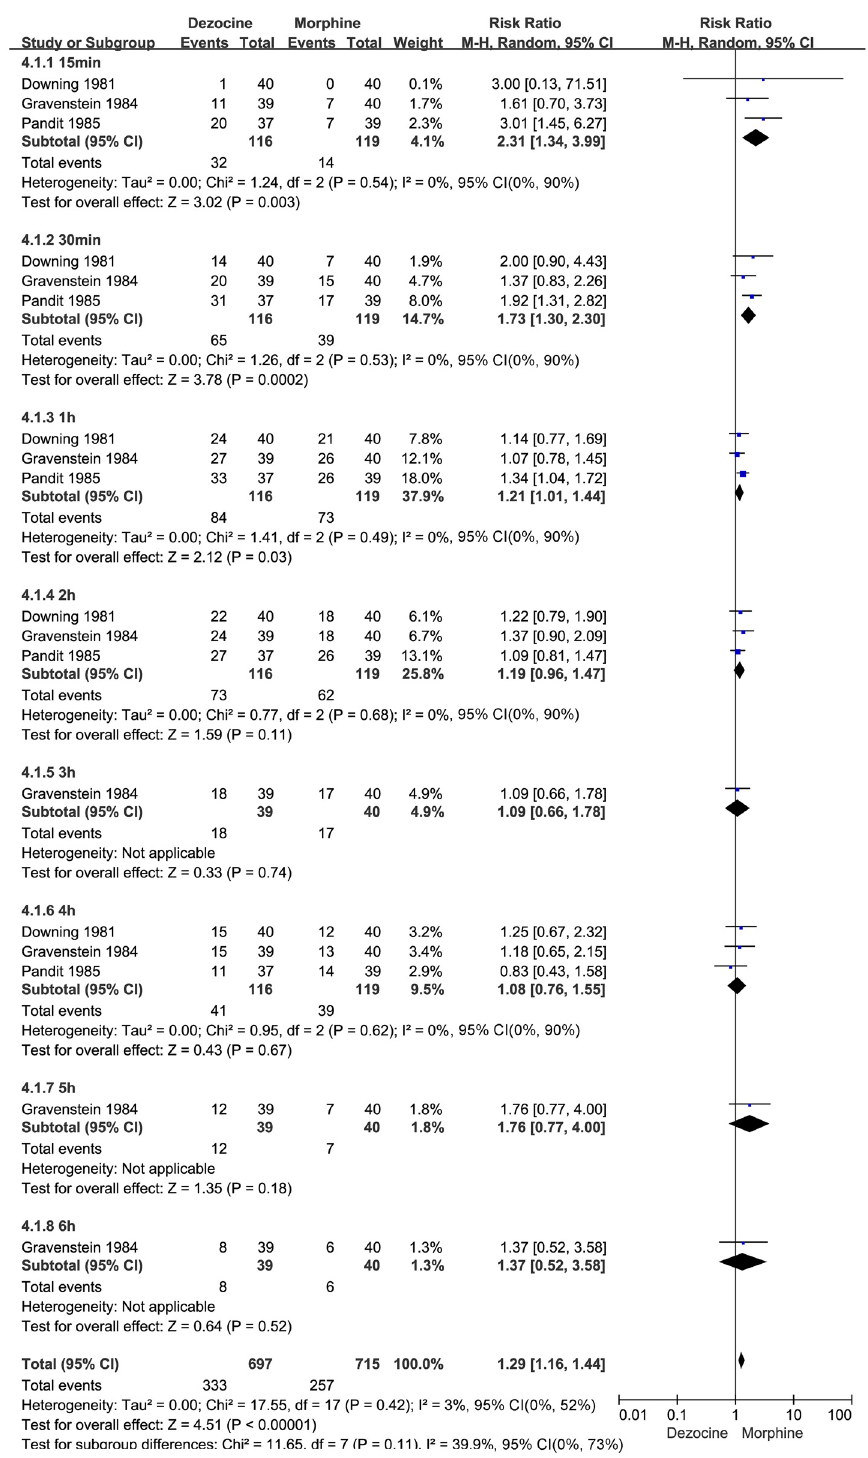
Fig 4. Forest plot of the effect of dezocine versus morphine on the overall evaluation of physician satisfaction after surgery. RR = relative risk; and CI = confidence interval.